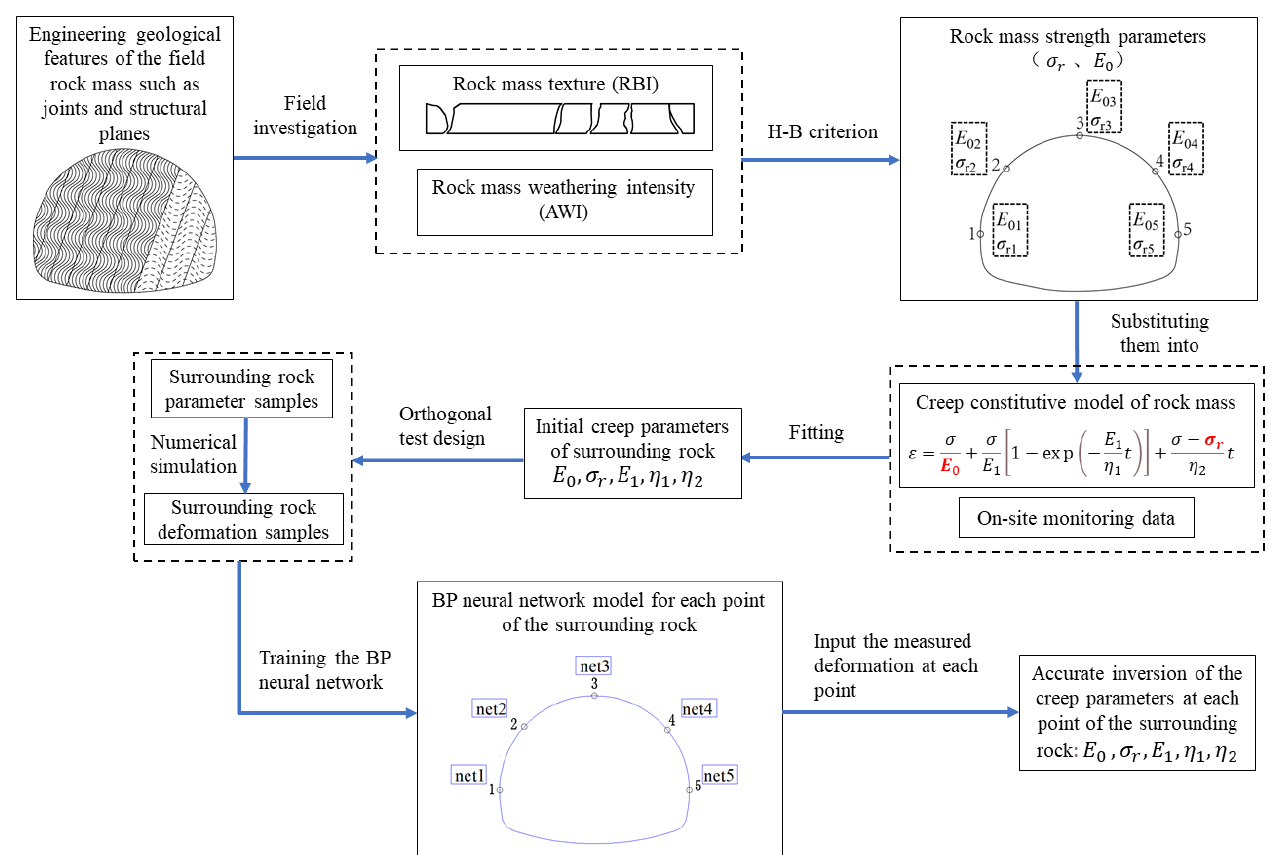
Figure 9. Inversion workflow for the creep parameters of the surrounding rock mass. The Ganbao tunnel project of the Wenchuan–Maerkang expressway was taken as an engineering case study. It is an ultra-long left-right separated tunnel project (the left tunnel is 4777 m long and the right one is 4796 m long). The longitudinal profile of the tunnel is illustrated in Figure 10, in which the red surrounding rock mass mainly represents the sericite phyllite; the yellow part represents the sericite phyllite interbedded by carbonaceous phyllite and metasandstone; the blue part shows the carbonaceous phyllite and sericite phyllite interbedded by metasandstone; the green part represents the sericite phyllite and carbonaceous phyllite; and the black part indicates the carbonaceous phyllite. The tunnel was excavated using the drilling and blasting method. A large deformation occurs at the mile sections K141 + 540~K141 + 860 and K143 + 485~K143 + 650, which results in the circumferential cracking of multiple points along the initially supported arch and local cracking and spalling of the sidewall and tunnel crown (Figure 11). The monitoring section is located at K143 + 621 and starts monitoring after 12 h of excavation. The overburden near the monitoring section consists of collapsed debris deposits, sericite phyllite and carbonaceous phyllite (from top to bottom, Figure 12),the lithology presented on the face of the surrounding rock mass of the largely-deformed tunnel section (Figure 13) is dominated by the carbonaceous phyllite and sericite phyllite, mainly the Grade-V surrounding rock mass. The rock mass is found with a laminated texture and has a buried depth of 646 m, with a vertical stress of 21.7 MPa and a horizontal stress of 8.3 MPa. Field observations indicate minimal effects of underground water, and thus the correction factor λ for the effects of underground water on the weathering conditions of the rock mass is set as one.